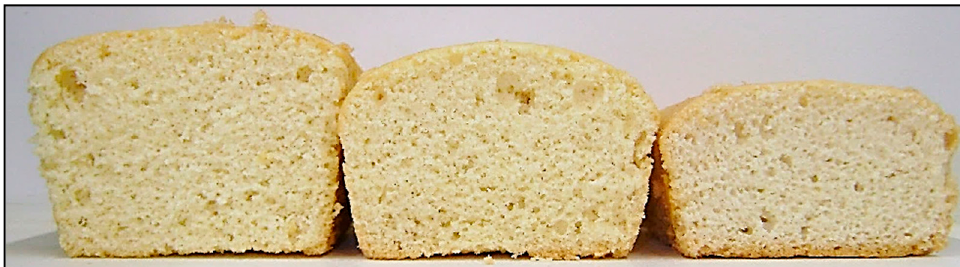
Figure 2. Sponge cakes prepared with (i) freeze-dried egg white and egg yolk (EW FD /EY FD , left), (ii) freeze-dried egg white and egg yolk with relocated lipids (EW FD /EY FD,RL , middle) and (iii) freeze-dried egg white and defatted egg yolk (EW FD /EY FD,D , right).